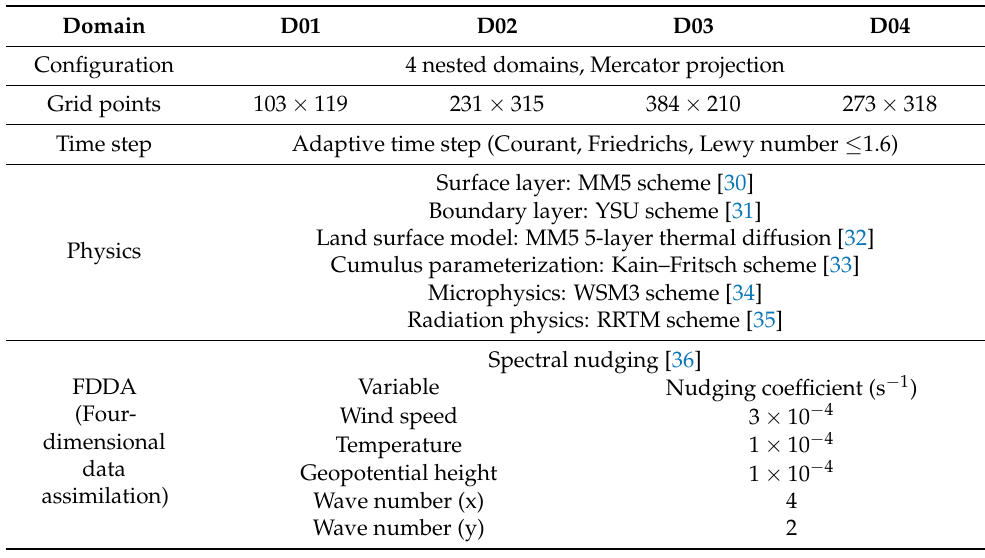
Table 3. Detailed settings of the WRF model. MM5: mesoscale model 5; YSU: Yonsei